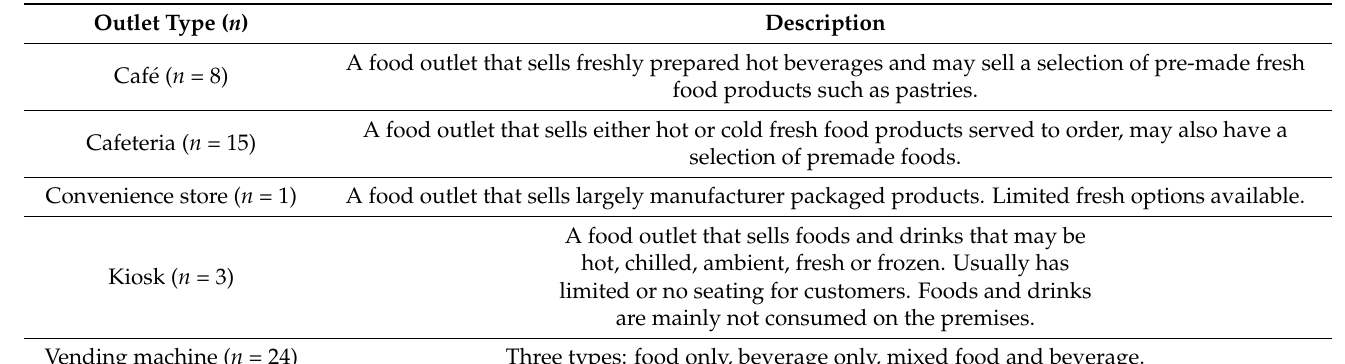
Table 1. Types and number of food outlets included in the study.